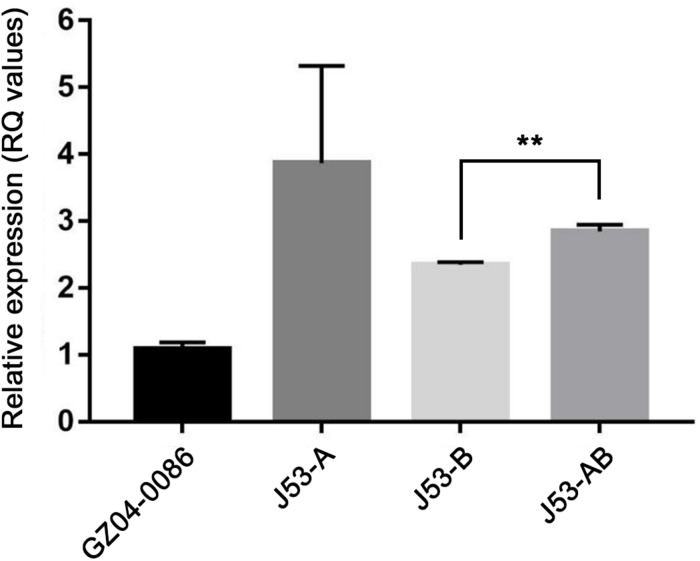
Relative expression of the blaNDM–5 gene among strain GZ04-0086 and transconjugants J53-A, J53-B and J53-AB. Strain GZ04-0086 was used as the reference. Asterisks above lines indicate a statistically significant difference (** P < 0.01) as determined by Student t test.